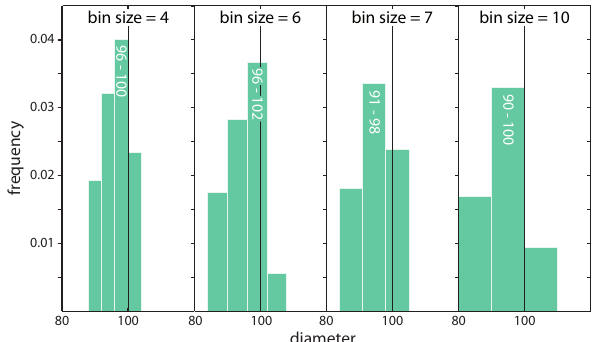
Figure 3. Plots showing the effect of choosing different bin sizes for the same data set. The monodisperse data set is formed by 5997 measurements. The actual grain size, taken as a reference point, was set at 100 and the absolute maximum uncertainty in measure within the data was set at ± 4 (4% of the actual size). For clarity, only the bins surrounding the actual grain size are shown. The left edge of the histogram was set at 0 and four different bin sizes were used. Note that the middle value of the modal interval is different in all cases although the population is the